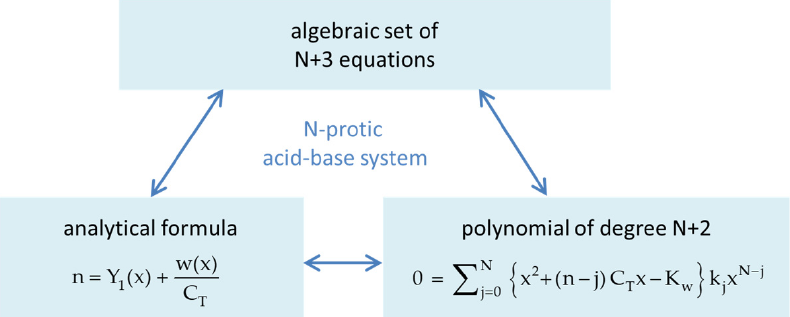
Figure 44. Three mathematically equivalent descriptions of the N-protic acid–base system. The